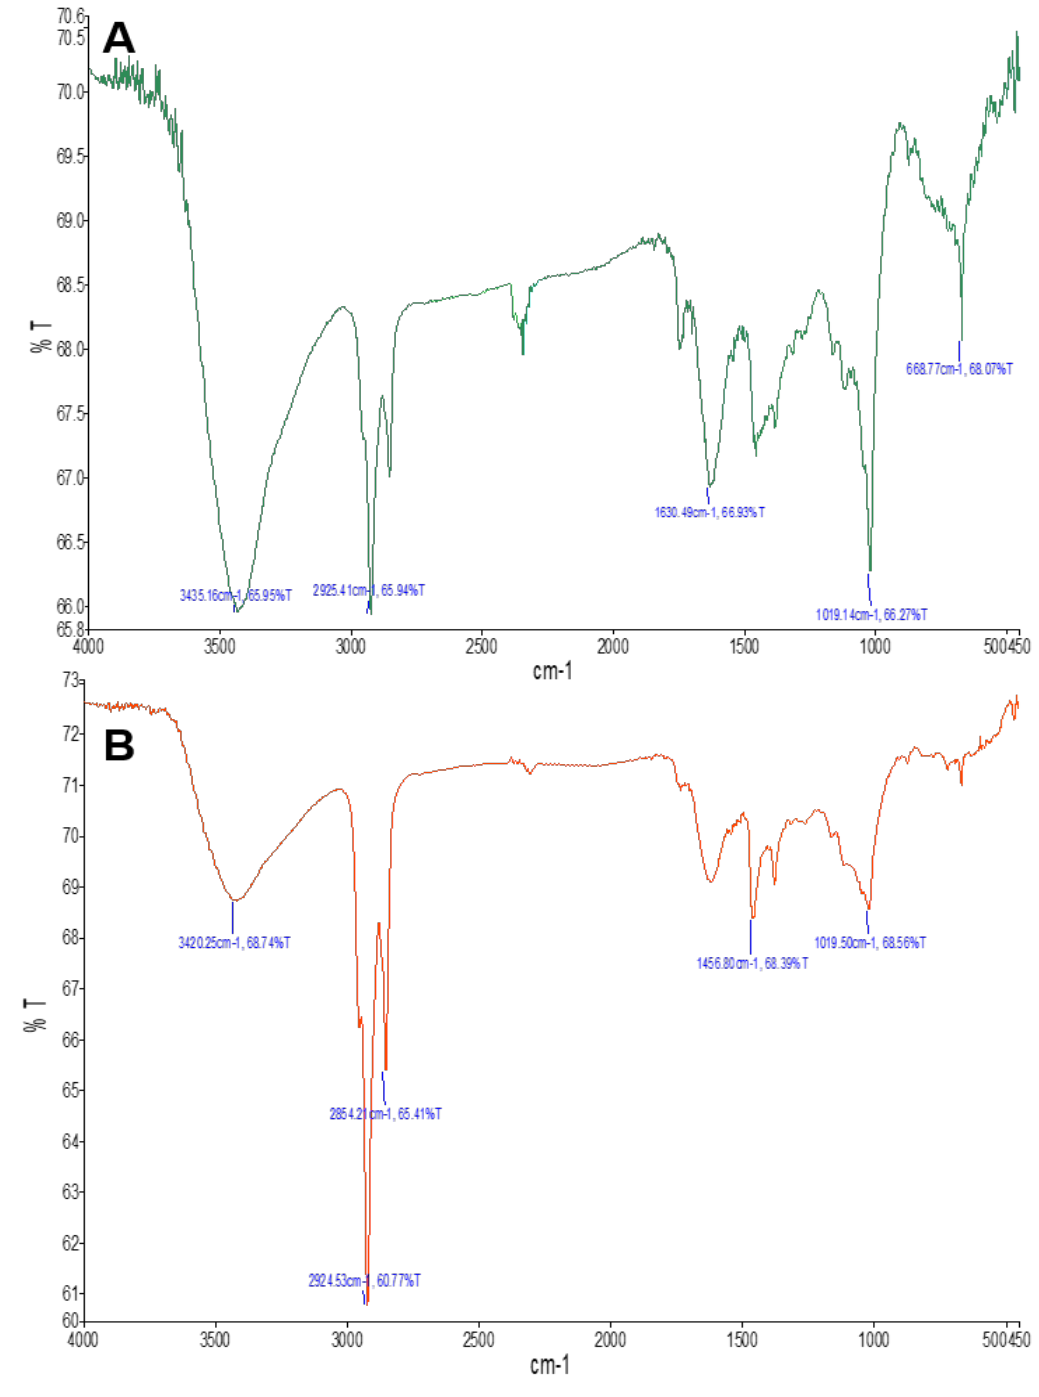
Figure 2. FTIR spectrum of Ajwa dates. ( A ) Seed extract; ( B ) AgNPs in the range of 4000 to 400 cm −1 .